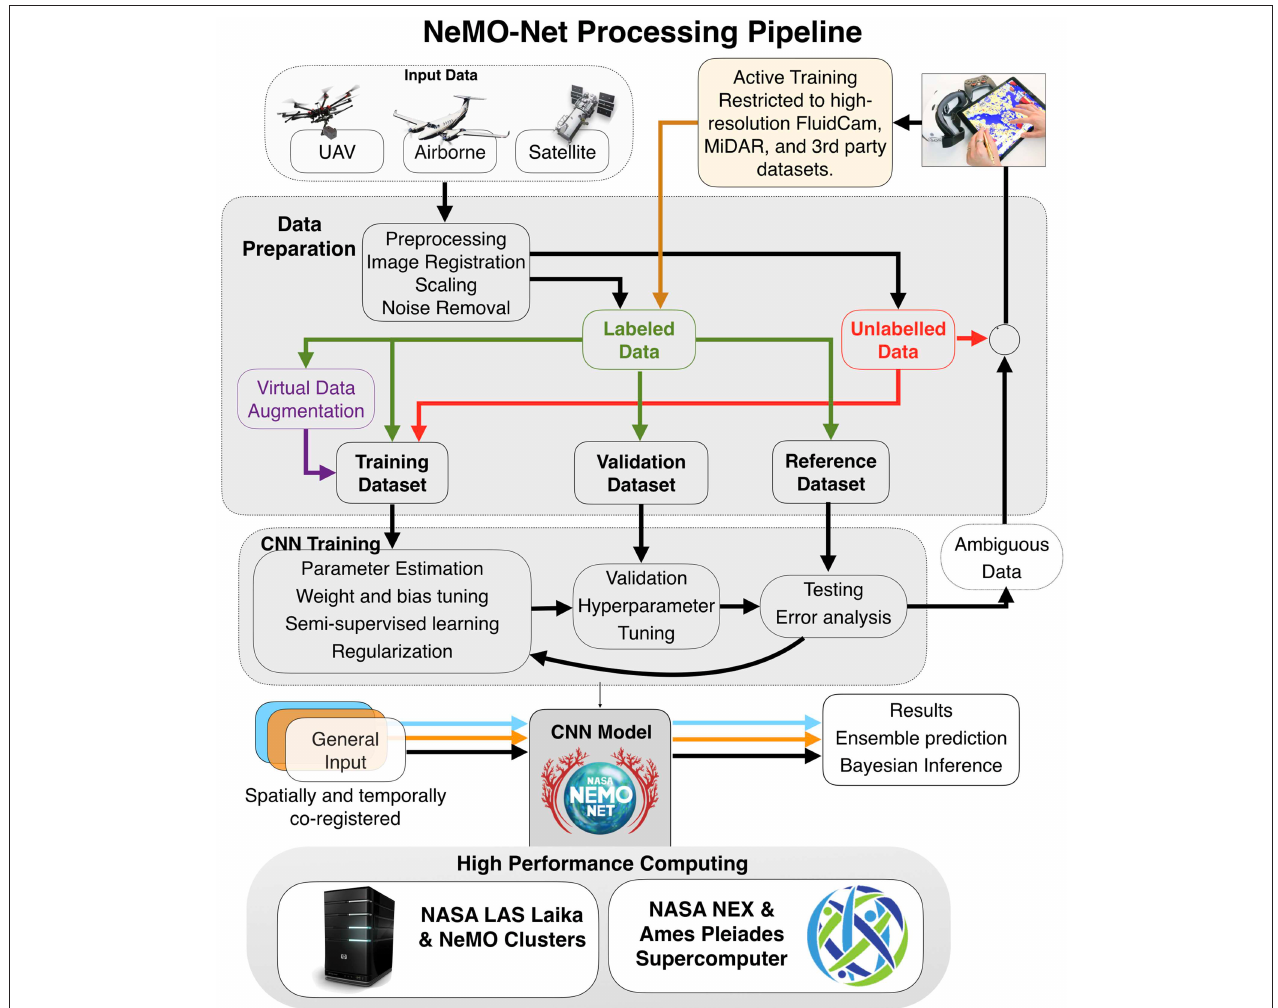
FIGURE 14 | NeMO-Net Processing Pipeline. UAV, airborne, and satellite data are preprocessed and split into labeled and unlabeled categories. Relevant training, validation, and reference sets are created and fed into the CNN training process. Ambiguous data sets are fed back into an active training section for active learning. The final CNN model takes spatially and temporally co-registered datasets, if available, and outputs predictions based upon ensemble or Bayesian inference techniques.